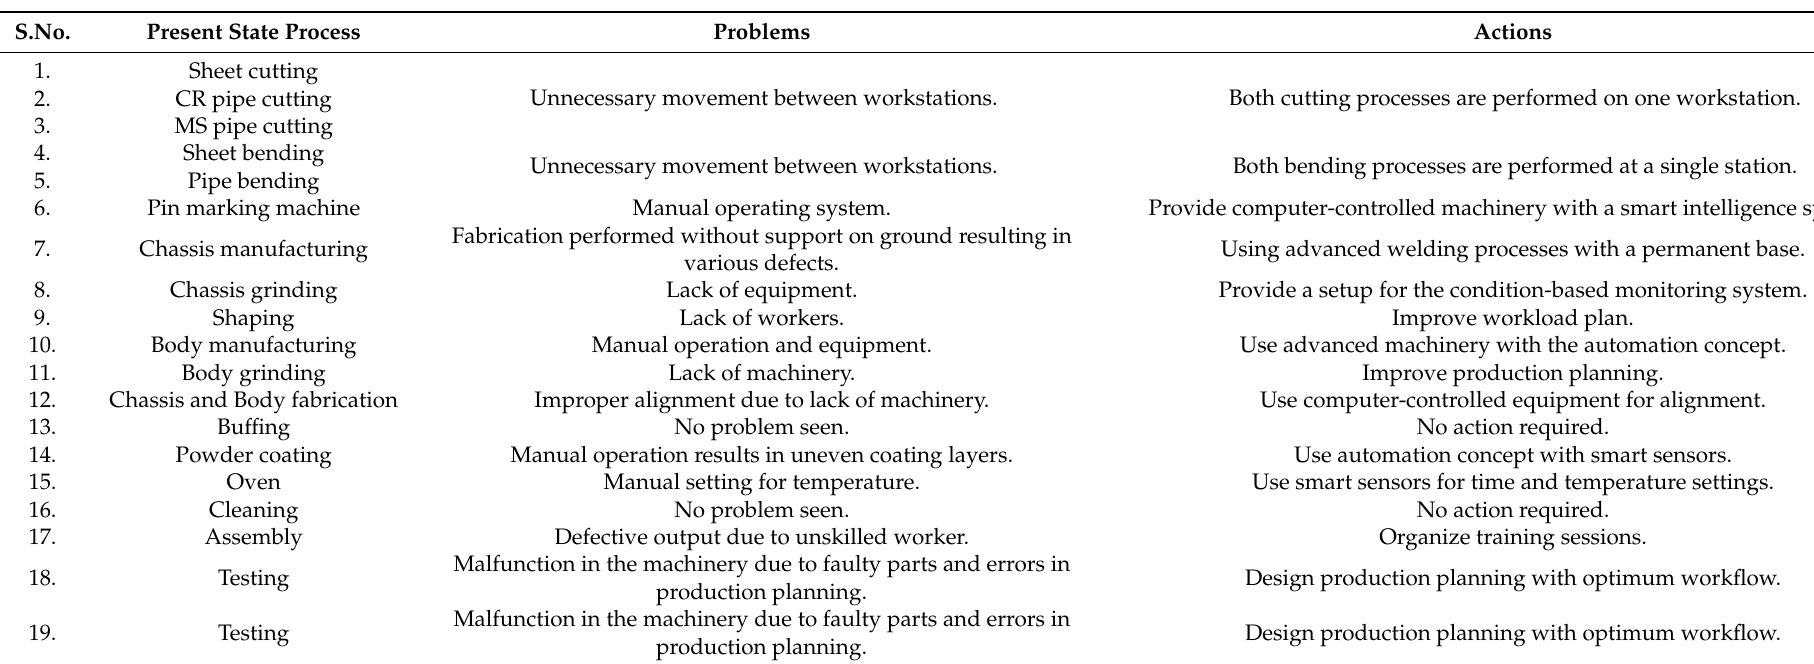
Table 7. Problem, Action, and Result / Results obtained by action taken against identified problems in industry